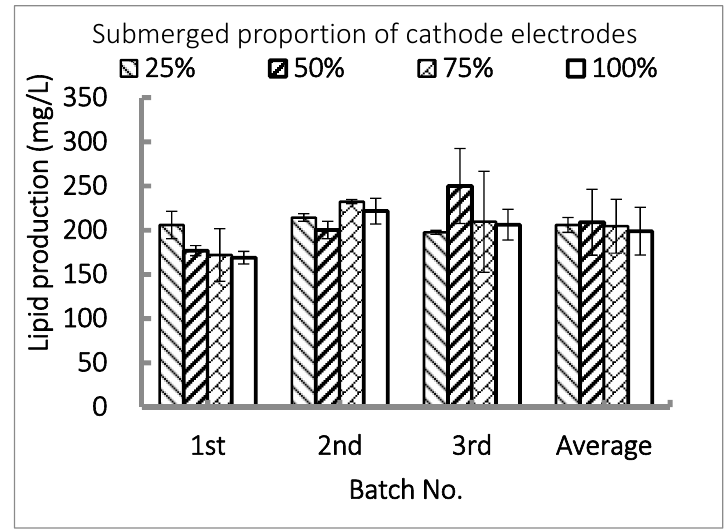
Figure A1. Lipid production of microalgae from wastewater with partially and completely submerged electrodes in the cathode chamber.